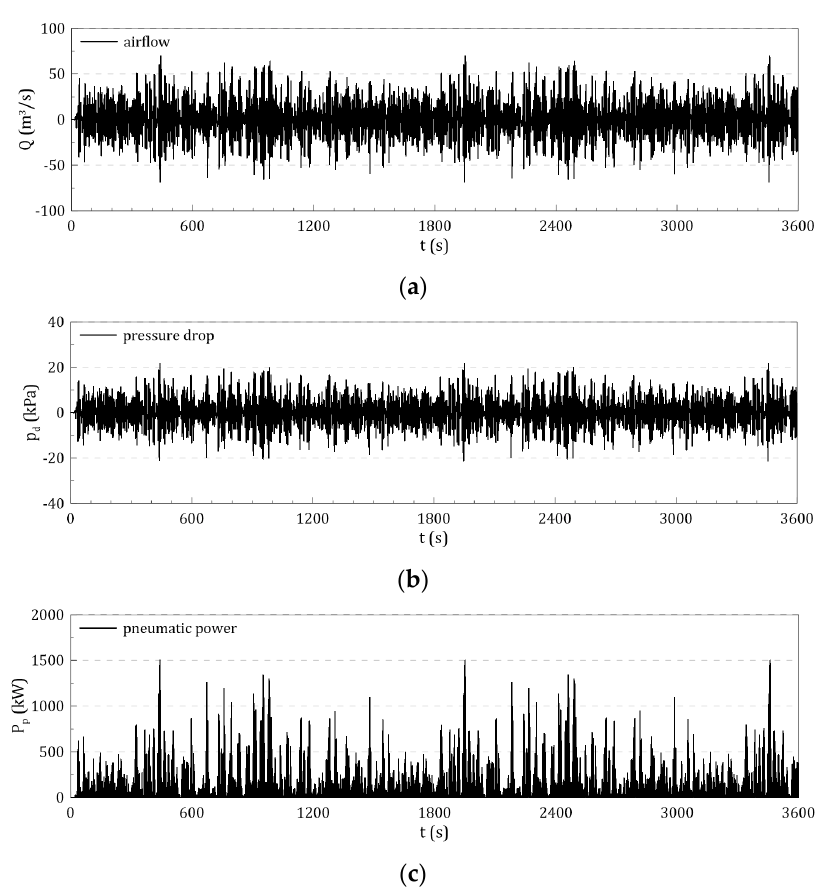
Figure 17. Time-series pneumatic responses of the OWC chamber from irregular wave simulation with the direct interaction method (DIM): ( a ) airflow; ( b ) pressure drop; ( c ) pneumatic power.